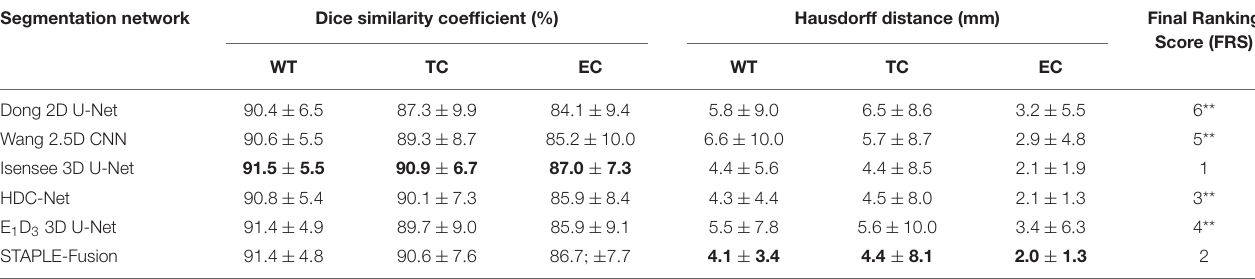
TABLE 4 | Performance of six segmentation schemes, including five CNNs and one STAPLE-fusion method, on testing cohorts A and B (60 subjects). Segmentation